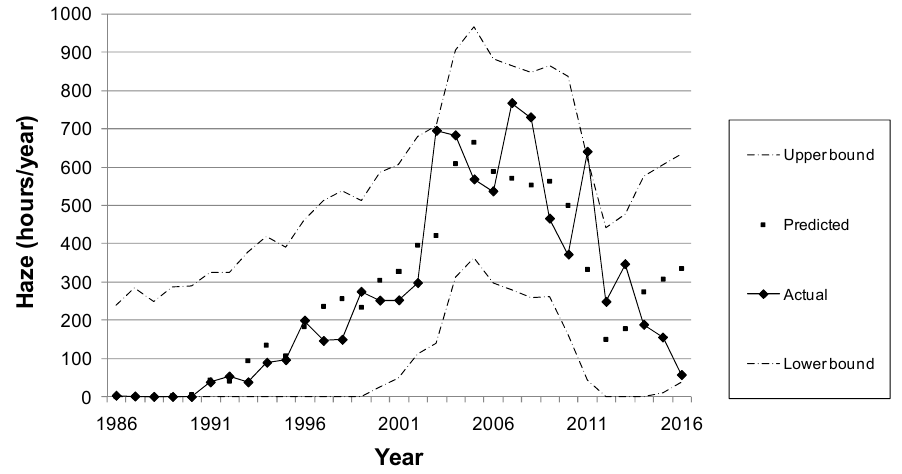
Figure 4. Variations in the actual and predicted number of hours of haze in Macao over the period 1986–2016.